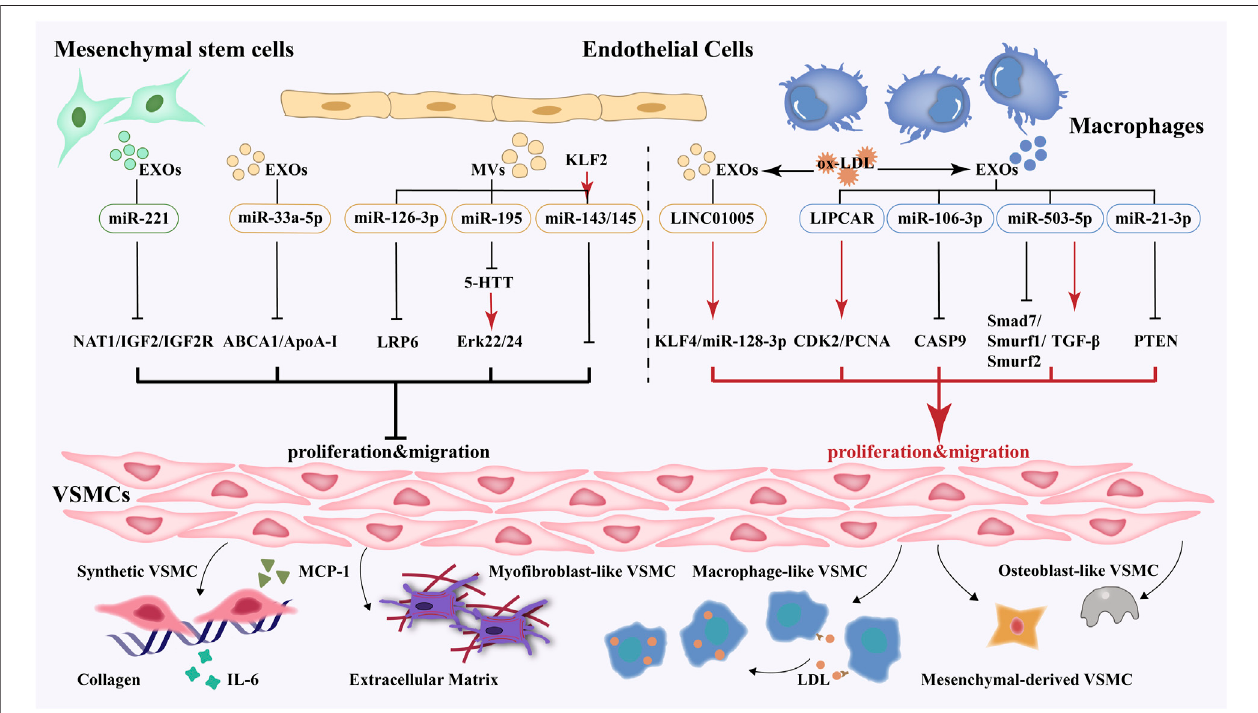
FIGURE 1 | EVs-mediated crosstalk between multiple cells and VSMCs and phenotype switching, proliferation, migration and secretion of VSMCs.